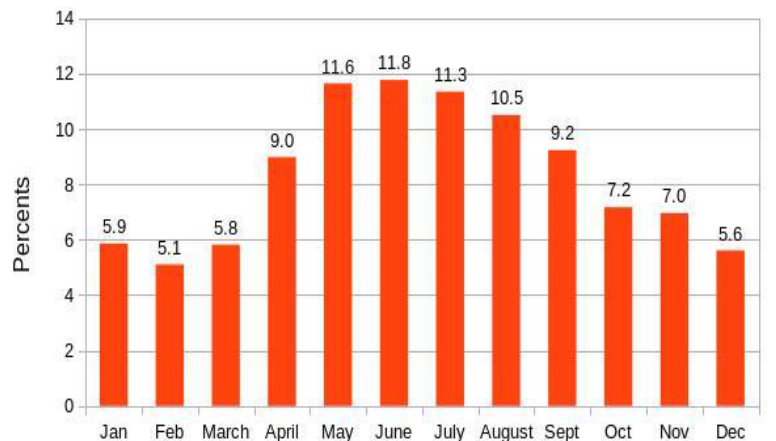
Figure 5. Monthly distribution of the number of days with flashes detected by ATDnet over the studied domain for the period 2012 – 2021.